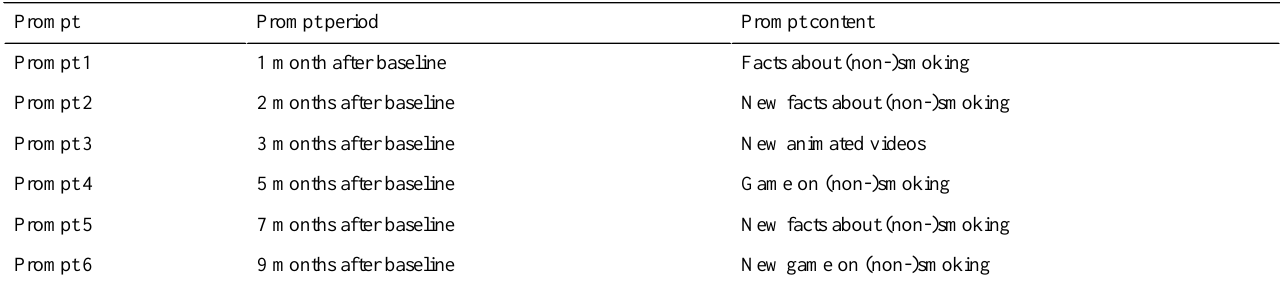
Table 1. Period and content of prompts posted on the